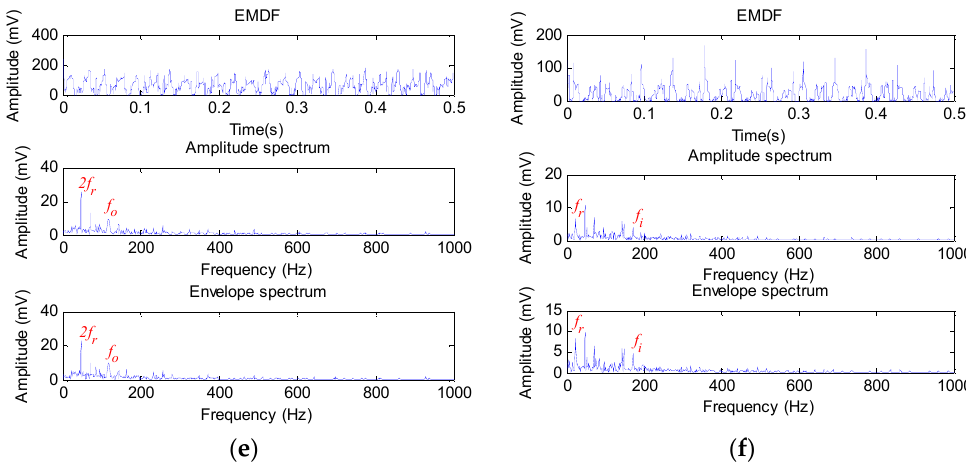
Figure 16. Analysis results obtained by different methods: ( a ) the results of AVG for outer race fault signal; ( b ) the results of AVG for inner race fault signal; ( c ) the results of STH for outer race fault signal; ( d ) the results of STH for inner race fault signal; ( e ) the results of EMDF for outer race fault signal; ( f ) the results of EMDF for inner race fault signal.